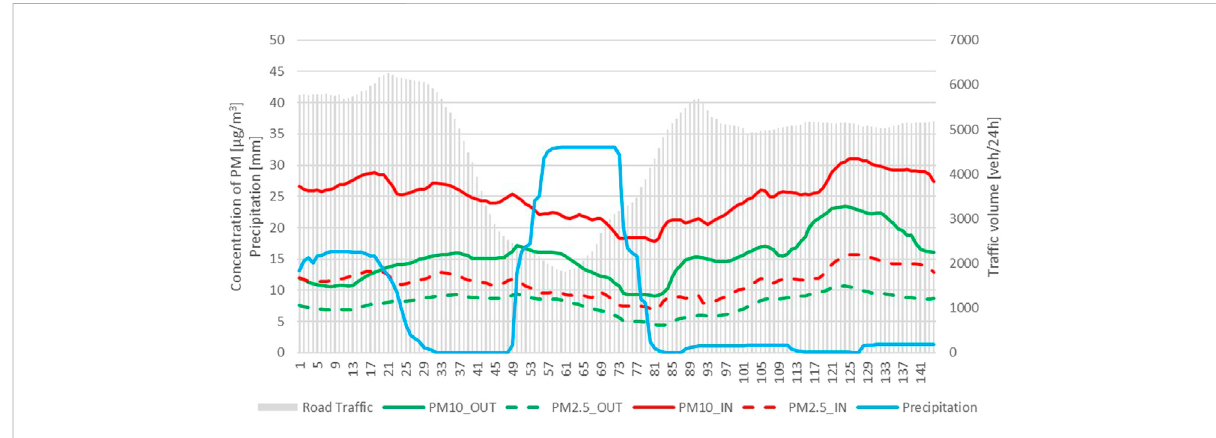
FIGURE 2 Trend of PM concentrations, traf fi c volume, and total precipitation during measurements in the Pova ž ský Chlmec tunnel in the period of 1/10/ 2020 – 7/10/2020.